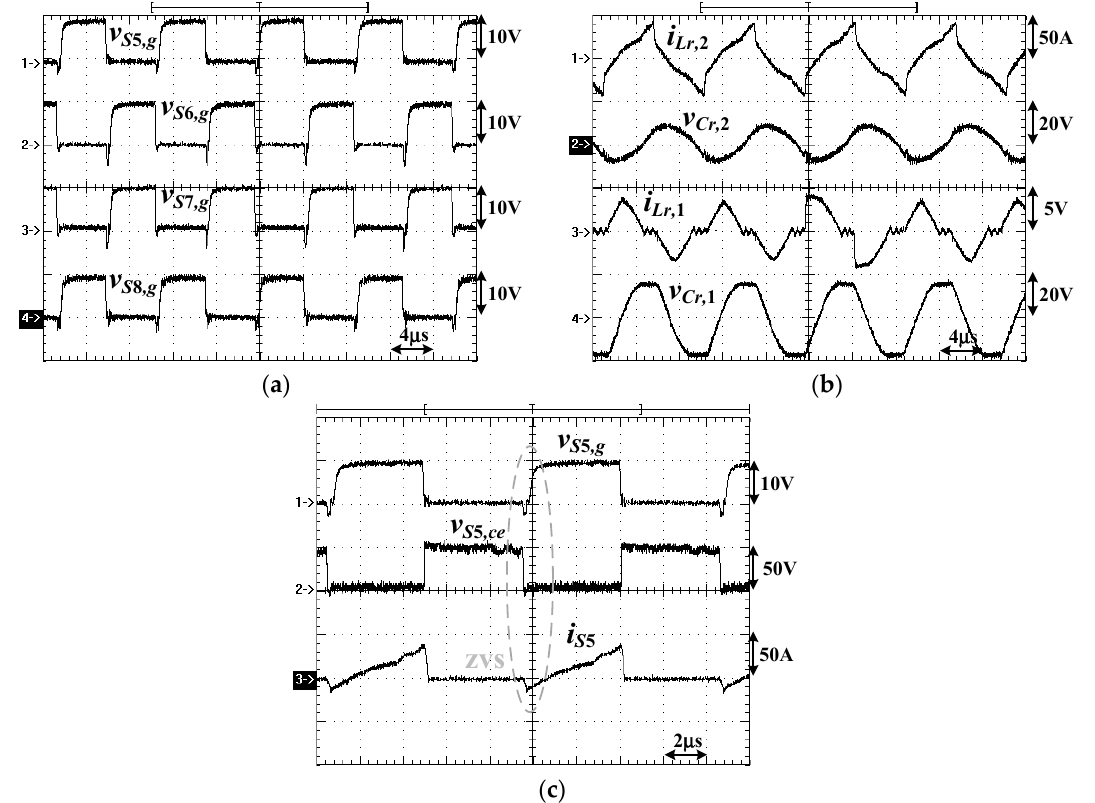
Figure 12. Measured results of the proposed converter under backward power flow operation with V o = 52 V and V in = 400 V A: ( a ) v S 5, g – v S 8, g ; ( b ) i Lr, 2 , v Cr, 2 , i Lr, 1 , and v Cr, 1 ; ( c ) v S 5, g , v S 5, ce , and i S 5 .